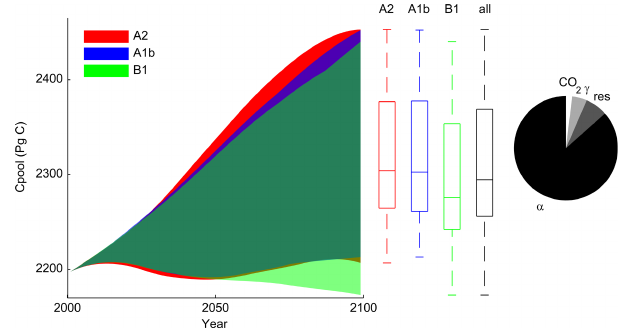
Fig. 6. Results of the 192 replacement model simulations using “ar- tificial GCM” input. The total spread of the A2 scenario simula- tions in total terrestrial carbon pool (Cpool) is illustrated in red. Blue shows the A1B scenario and green the B1 scenario. The box- plots show the median, 25th and 75th percentile, and maximum and minimum values of the 2099 total terrestrial carbon pool (PgC), for each CO 2 scenario and all simulations. The pie chart shows the proportion of 2099 total carbon pool variability explained by, α , γ , CO 2 scenarios and residual unexplained variation